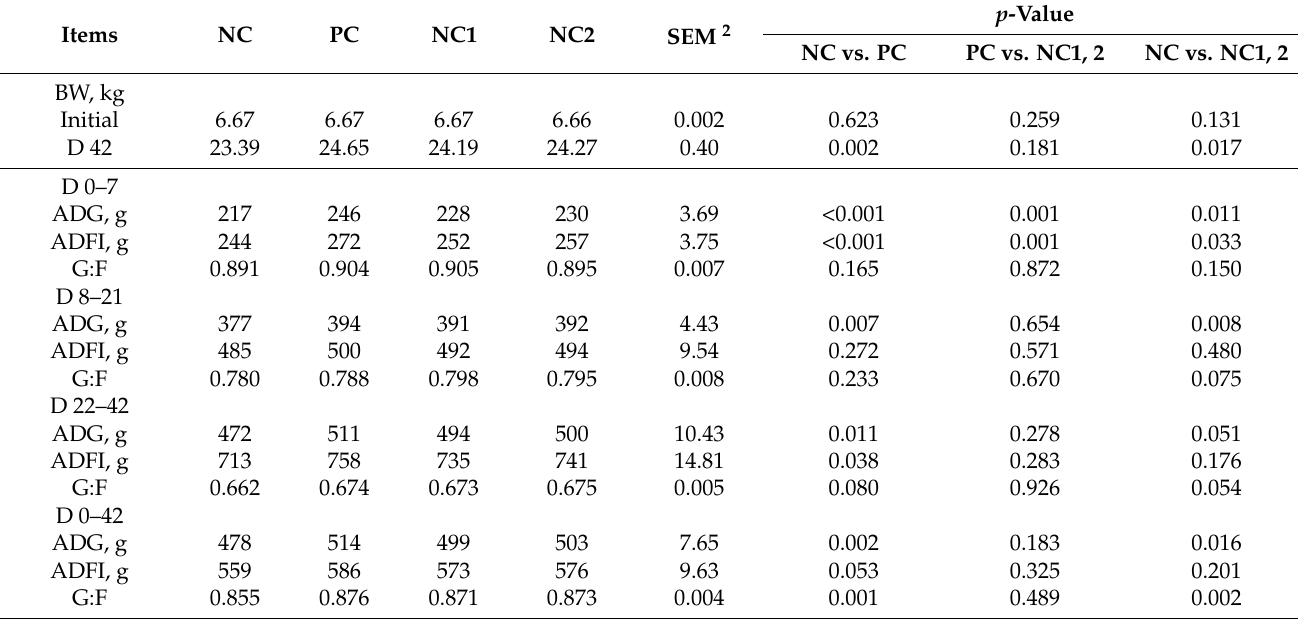
Table 2. Effect of dietary Lactobacillus plantarum BG0001 supplementation on growth performance in weaning pigs 1 .